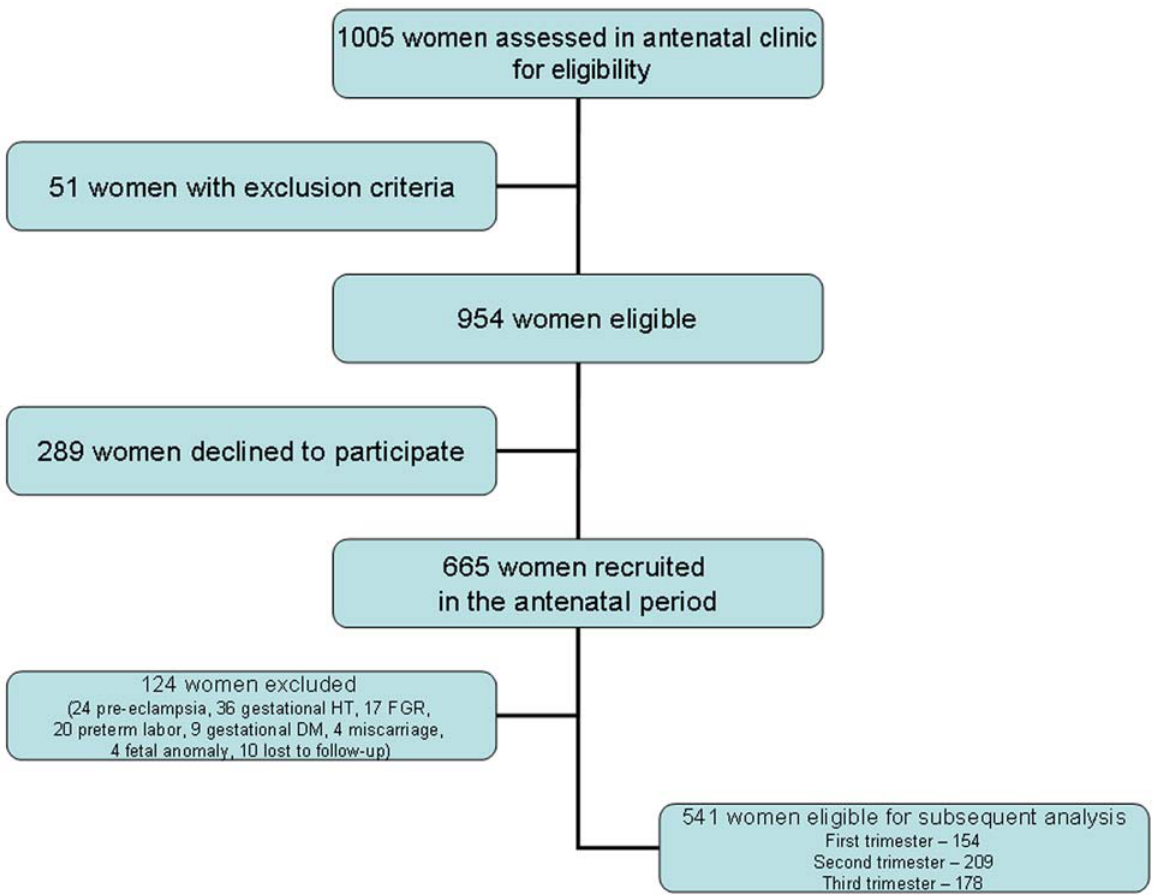
Figure 1. Recruitment and progression of participants through the trial.